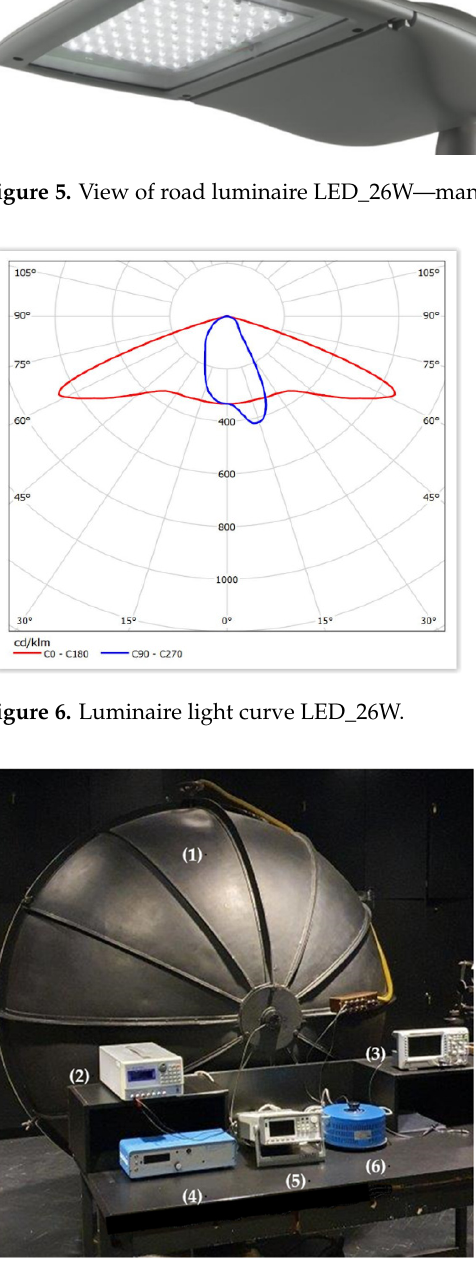
Figure 7. The station for determining control characteristics: (1) Integrating sphere, (2) programmable DC power supply, (3) oscilloscope, (4) photometer, (5) power analyzer, (6) autotransformer.